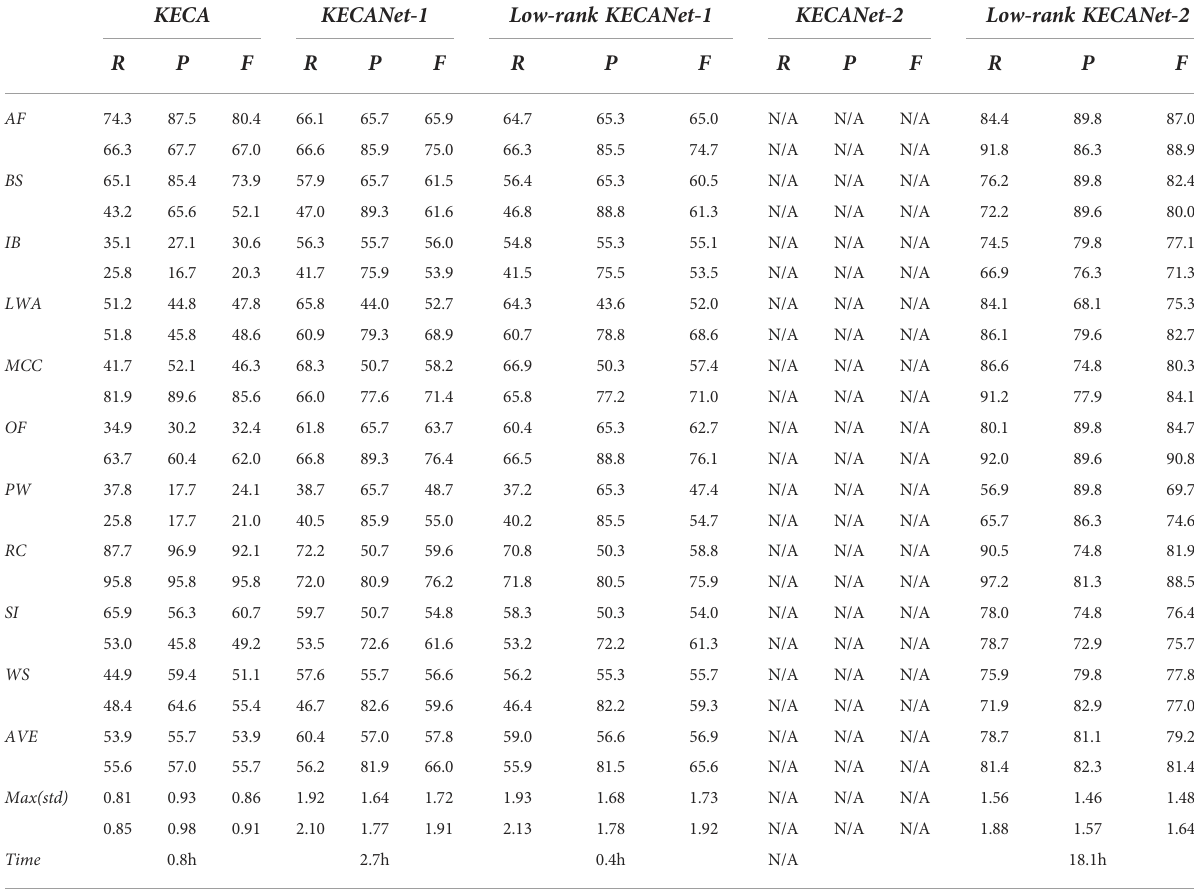
TABLE 2 Ablation Study of KECA on WV1 (upper) and WV2 (lower) imagette recognition (%).